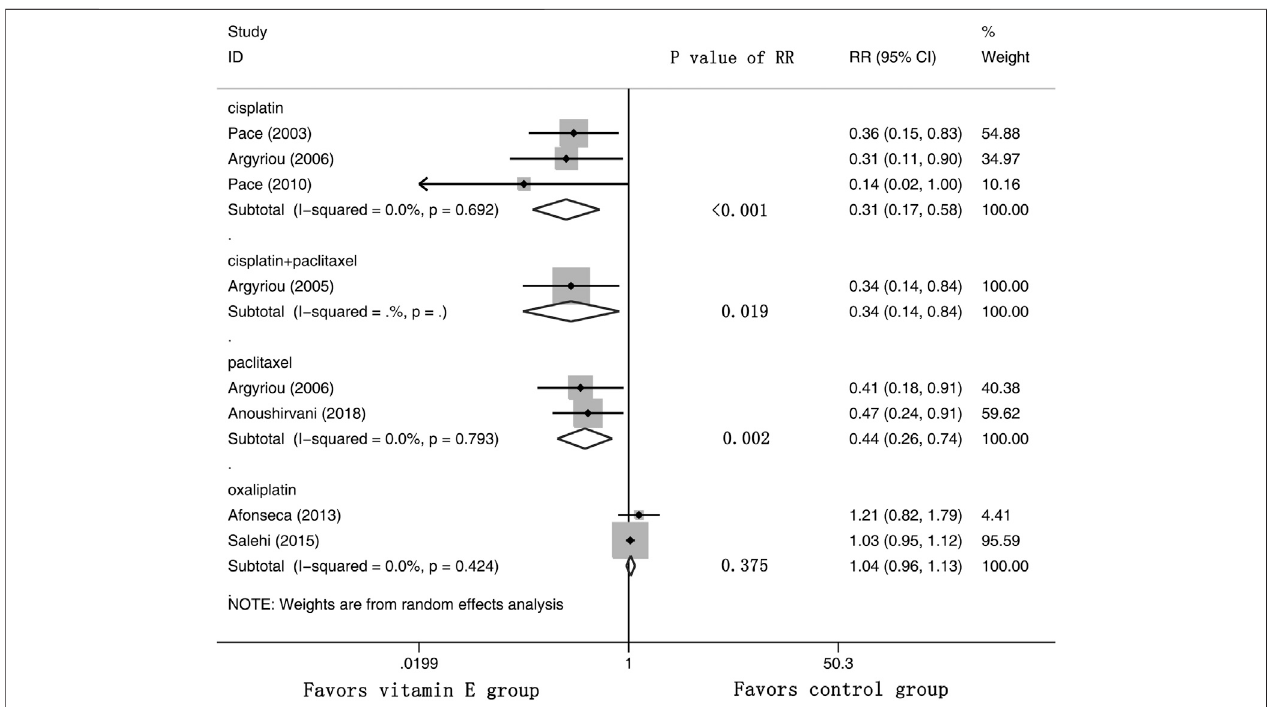
FIGURE 4 | Forest plot of the subgroup analysis of incidence of all-grade CIPN in VE and control groups. Summary of the subgroup analysis of incidence of all- gradeCIPNRRbetweenVEandcontrolgroupswerecalculatedusingtherandomeffectmodel.VE,vitaminE;CIPN,chemotherapy-inducedperipheralneuropathy;RR, risk ratio; P, p value of the Q test for